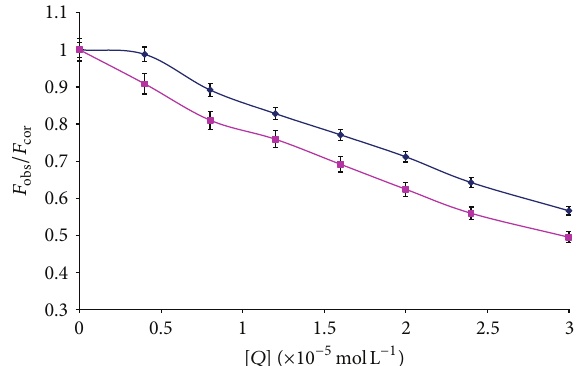
Figure 7: The quenching of HAase synchronous fluorescence by = 2.0 × 10 −6 molL −1 , ( X ) Δ𝜆 = 15 nm and liquiritigenin. 𝐶 HAase ( ◼ ) Δ𝜆 = 60 nm ( 𝑛 = 3 ).